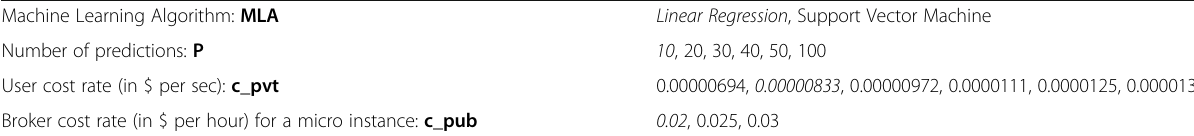
Table 5 Summary of System Parameters Machine Learning Algorithm: MLA Linear Regression , Support Vector